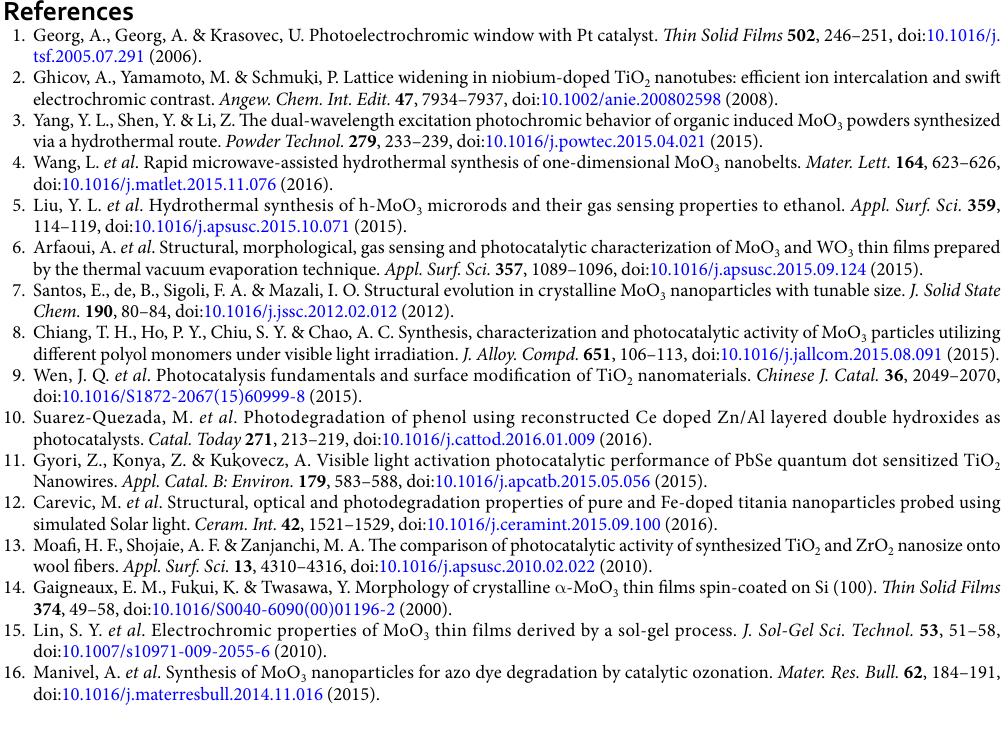
scanning rate of 0.1 sec/step in the range from 5° to 70°. The surface morphology of the MoO 3 powder was char- acterized by scanning election microscopy operated (SEM, Quanta 250, USA). The microstructure of the MoO 3 powder was characterized by transmission electron microscopy (TEM, FEI Tecnai G2 F20, USA). The presence of surface functional groups on the MoO 3 crystals were evaluated with Fourier transform infrared spectroscopy (FT-IR, Bruker vertex 80 V, Germany) analysis from 400 to 4000 cm − 1 . The Brunaner-Emmett-Teller (BET) spe- cific surface areas of the powders were analyzed by nitrogen adsorption (JW-BK122W, China). The composition of the MoO 3 was analysis by X-ray photoelectron spectroscopy (XPS, ESCALAB 250Xi, USA). The transmittance and reflectance spectra of the films were recorded using a UV-Vis spectrophotometer (Lambda 750s, USA) in the spectral range 300–800 nm. Photoluminescence spectra of the samples were recorded using a Fluoscence spec- trophotometer (VARIAN 3000, USA). Photocatalytic properties characterization.